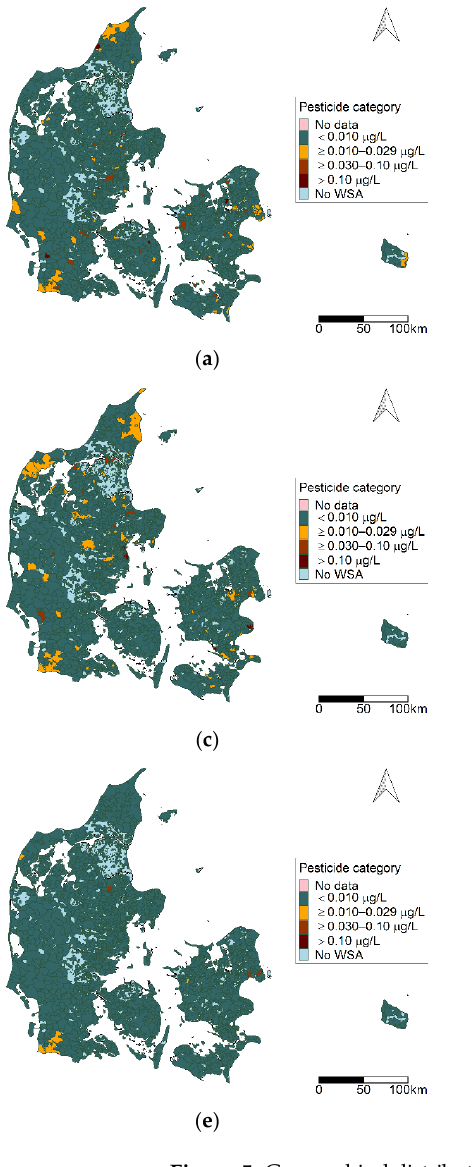
Figure 5. Geographical distribution of factor components 1 – 5 ( a – e ) for 2002 – 2011, illustrating the pesticide category for pesticides representing the given factor. ( f ) The WSA where multiple factor components were identified. Note that one WSA can represent multiple waterworks, and shows the maximum category represented by the WSA. Abbreviations: WSA: water supply area. Map contains data from the Danish Agency for Data Supply and Efficiency, municipality borders,